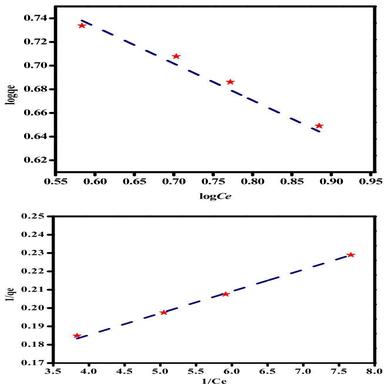
(A). Adsorption isotherm (B). Adsorption isotherm.